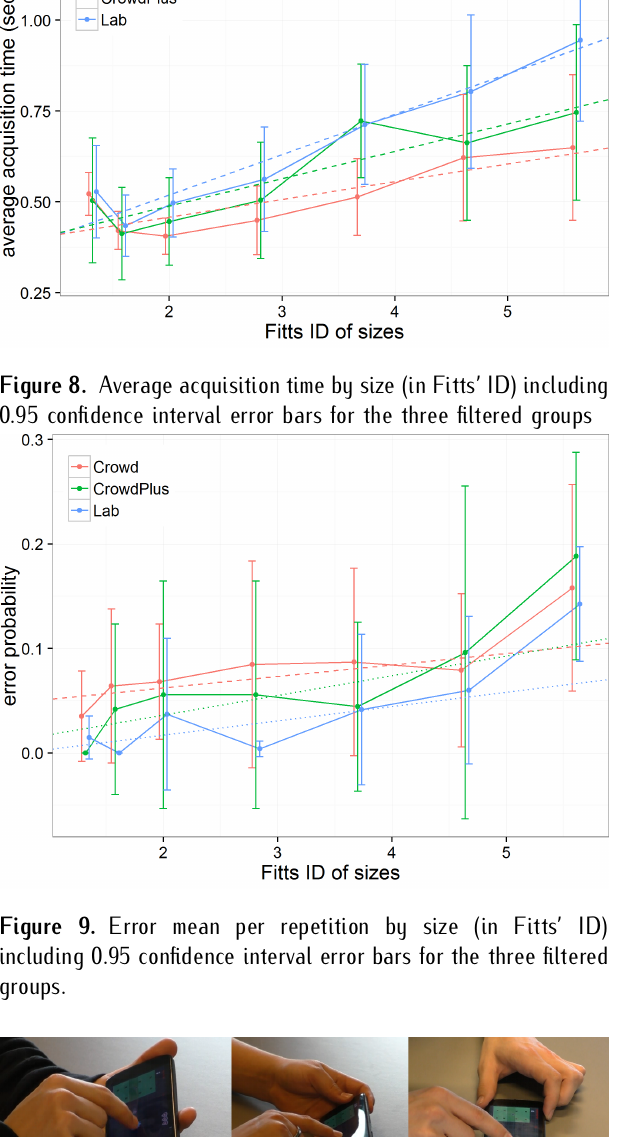
up either using one hand (see A, B, E in Figure 10) or placing the phone on the table (see C, D in Figure 10). When going from firm grip to the other grip types meant going from thumb to index